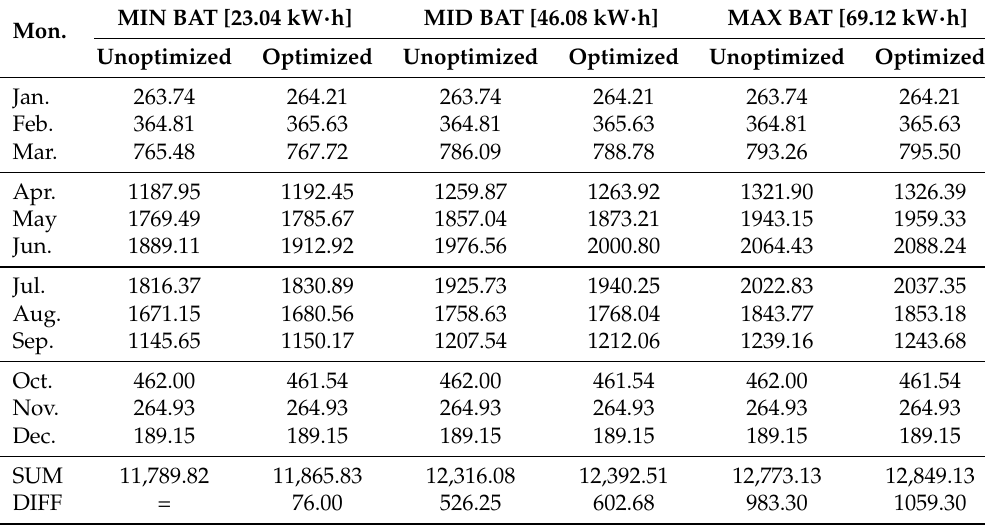
Table 7. Monthly energy savings in kWh calculated for each solution to compare their efficiency applying MAX _ charge scenario. SUM represents the total savings of the given solution during the year.